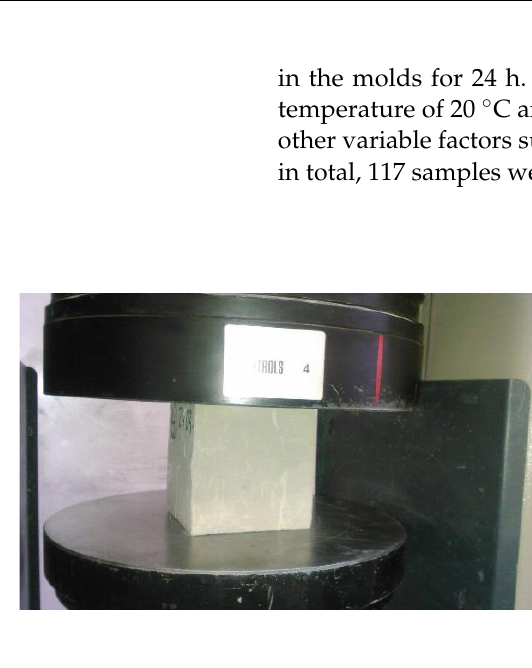
7 of 21 Figure 5. Exemplary foam concrete samples: ( a ) after filling the molds; ( b ) before cutting and testing. 2.3. Testing Methods The compressive strength was tested on the cubic specimens 100 × 100 × 100 mm 3 (Figure 6a), according to the standard PN-EN 12390-3:2019-07 [36]. These cubic samples were produced both directly from the molds of the same dimensions as well as from the bigger ones (300 × 300 × 100 mm 3 ), after a cutting process. All specimens were stored in the molds for 24 h. Next, the demolded samples continued curing for 28 days at a temper- ature of 20 °C and 60% relative humidity. Considering the different densities and other variable factors such as cement type, foaming agent, foam density and filling agent, in total, 117 samples were tested. The thermal conductivity was measured using the thermal analyzer Isomet 2114 [37], which is a multi-functional device for the measurement of thermal conductivity, thermal diffusivity and volume heat capacity. In the performed tests, the surface probe with the measurements range 0.04 – 0.3 Wm −1 K −1 was used. The device applies a dynamic measure- ment method, which reduces the measurement time in comparison with steady-state measurement methods. The dynamic method is based on the analysis of the temperature response of the analyzed material to heat flow impulses. Heat flow is excited by electrical heating of a resistor heater inserted into the probe which is in direct heat contact with the tested specimen. The evaluation of thermal conductivity is based on periodically sampled temperature records as a function of time, provided that heat propagation occurs in an unlimited medium. The measurement with the described device does not require any cal- culations and the results of the thermal conductivity measurement are visible on the dis- play and recorded in a file after the measurement is completed. The advantage of this